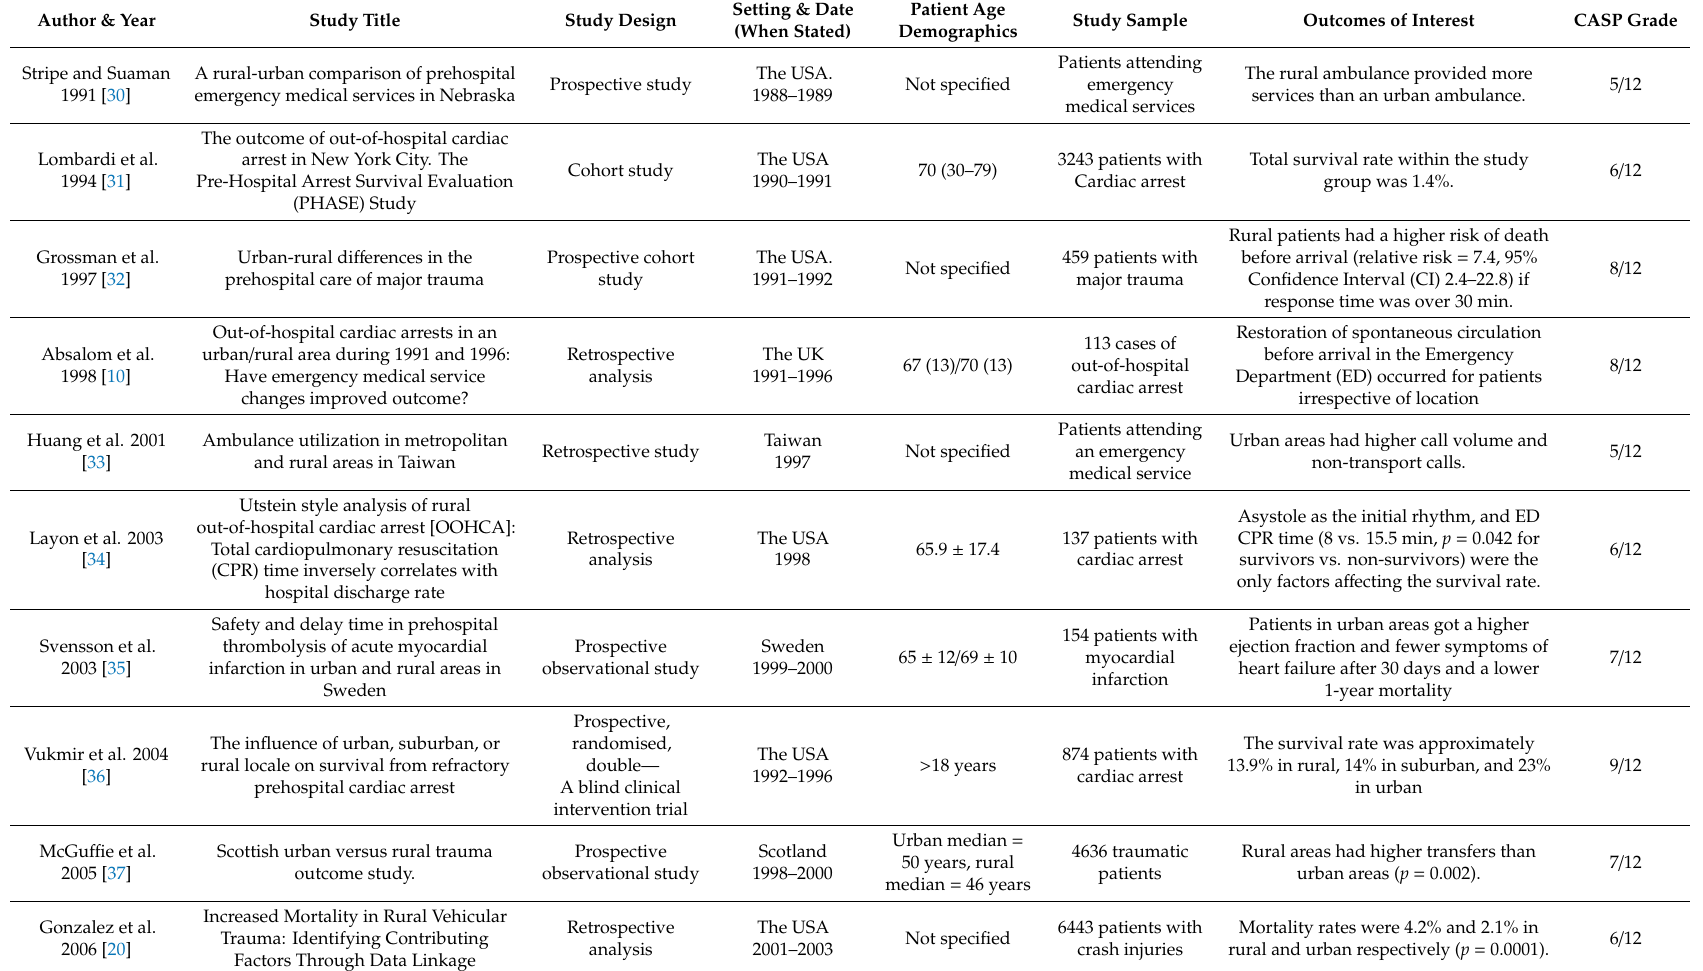
Table 1. Overview and quality assessment of